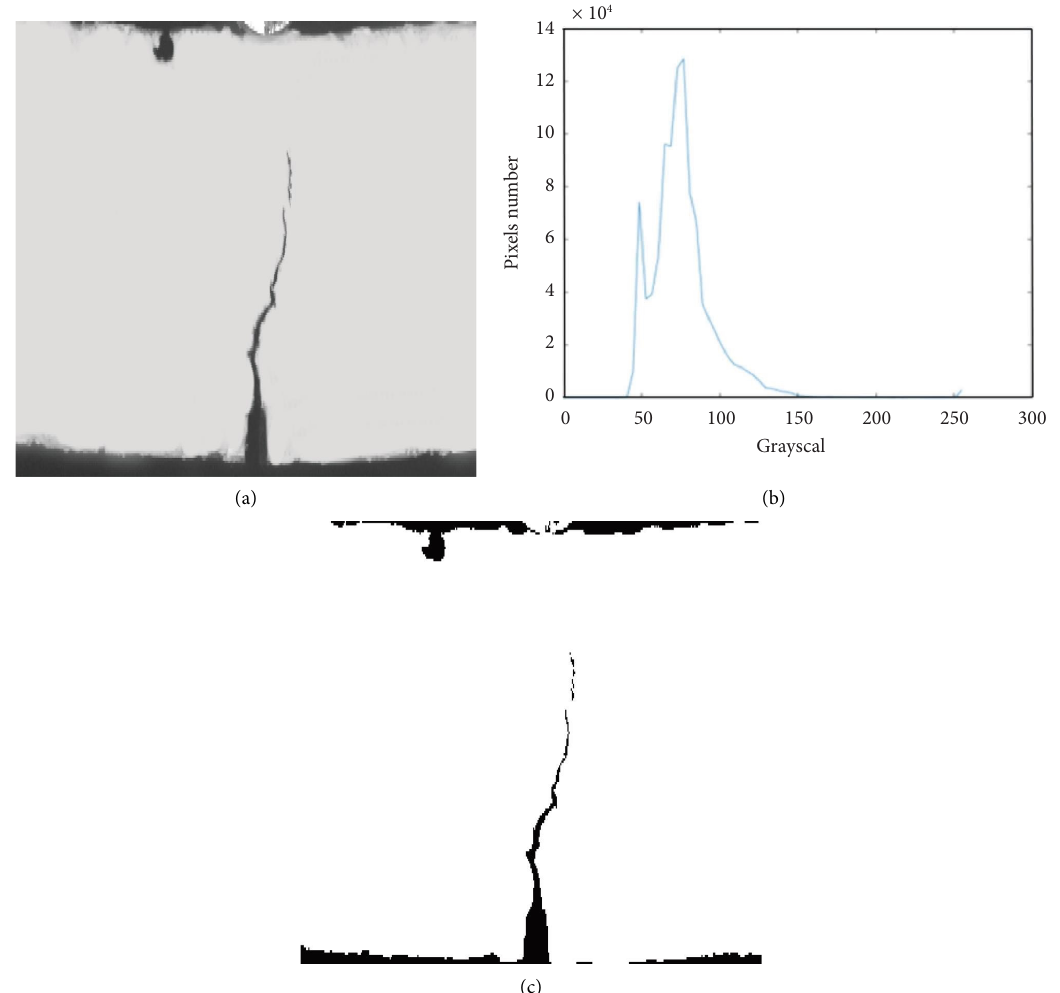
Figure 10: Generation of fracture binary graph: (a) Grey chart of the crack; (b) the appropriate threshold; (c) binary map of the